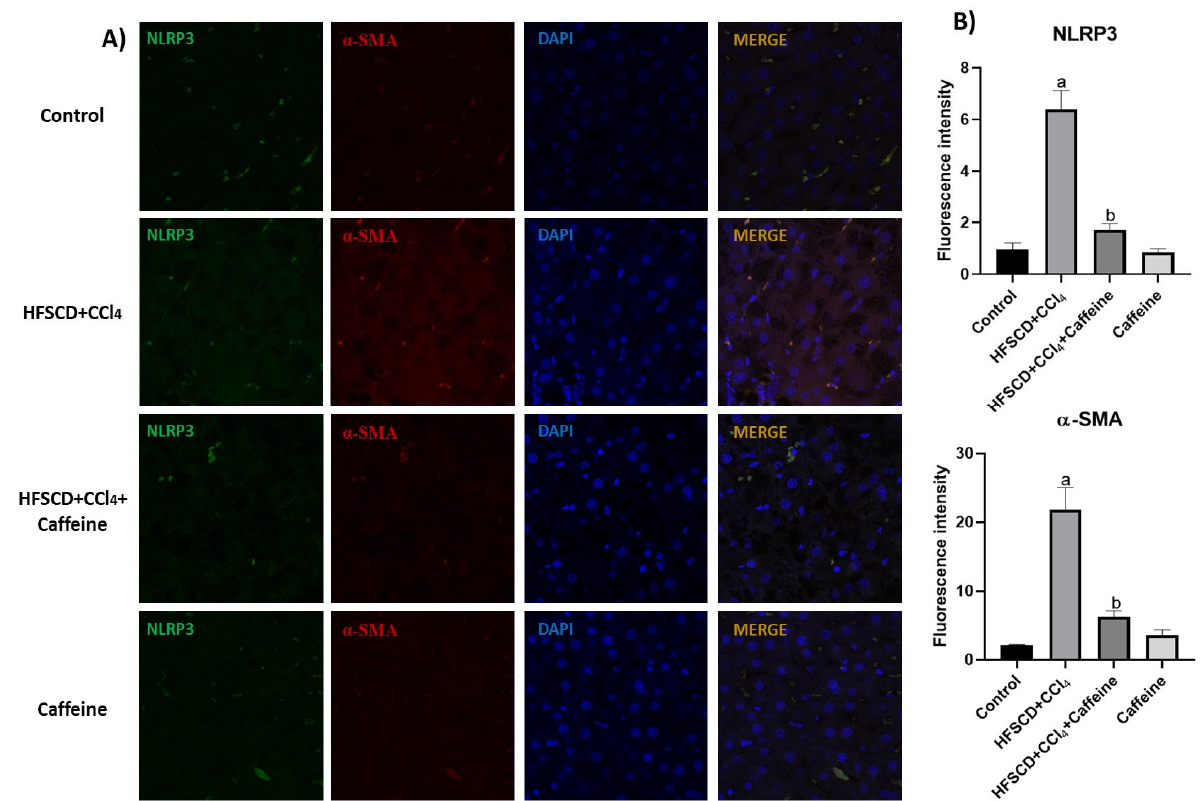
Figure 6. Effect of caffeine on NLRP3/ α -SMA dual-labeling in hepatic tissue from the NASH model. ( A ) IF analysis of NLRP3/ α -SMA in hepatic tissues from rats in the control, HFSCD+CCl 4 , HFSCD+CCl 4 +caffeine, and caffeine groups. ( B ) Quantification of fluorescence intensity of NLRP3 and α -SMA (n = 3). Bars represent the mean ± SEM. (a) p < 0.05 compared with the control group; (b) p < 0.05 compared with the HFSCD+CCl 4 group. The slides were observed under a confocal microscope at 63× magnification.